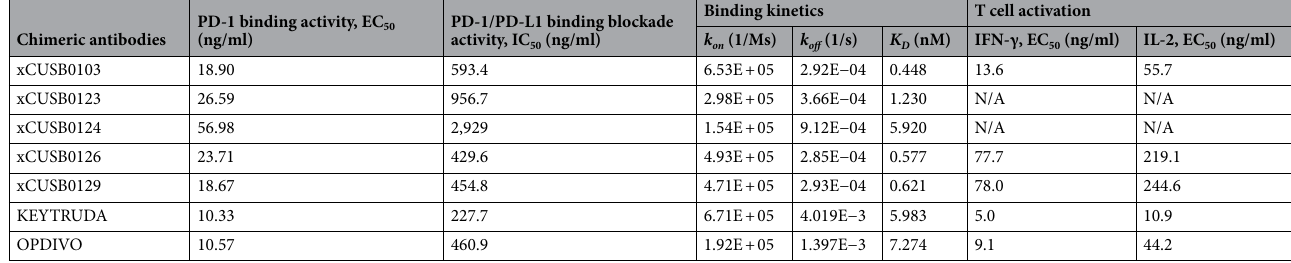
Table 2. Functional properties of chimeric anti-PD-1 monoclonal antibodies. N/A Not